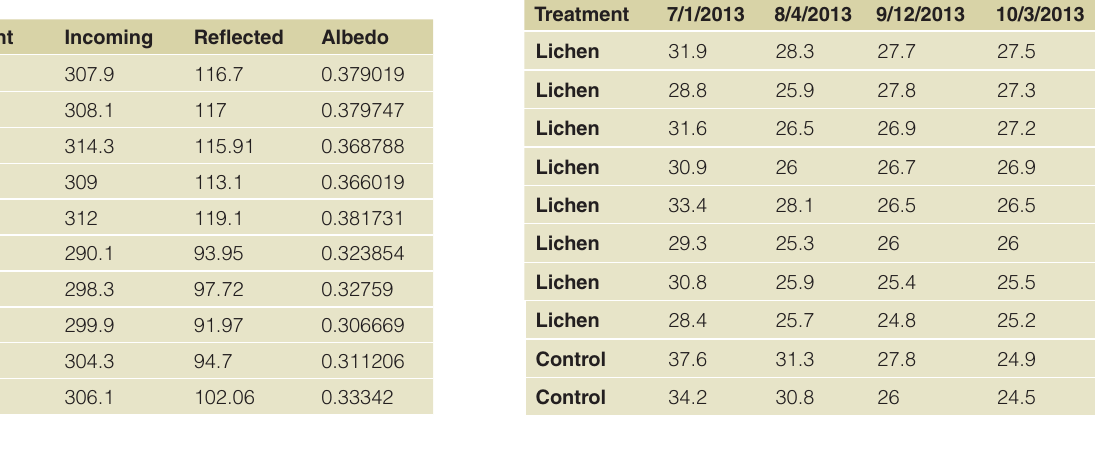
Data Set 2. Raw temperature data ( ° C) for the lichen modules and substrate only controls during the 2012 growing season